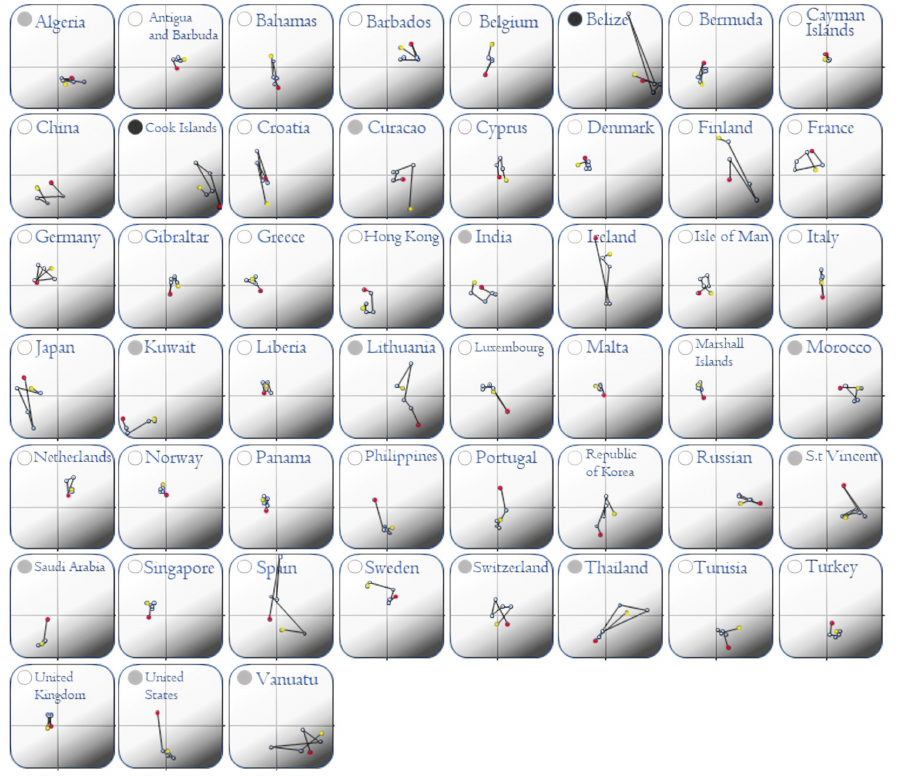
Figure 5. X-STATIS analysis trajectories for countries between 2013 and